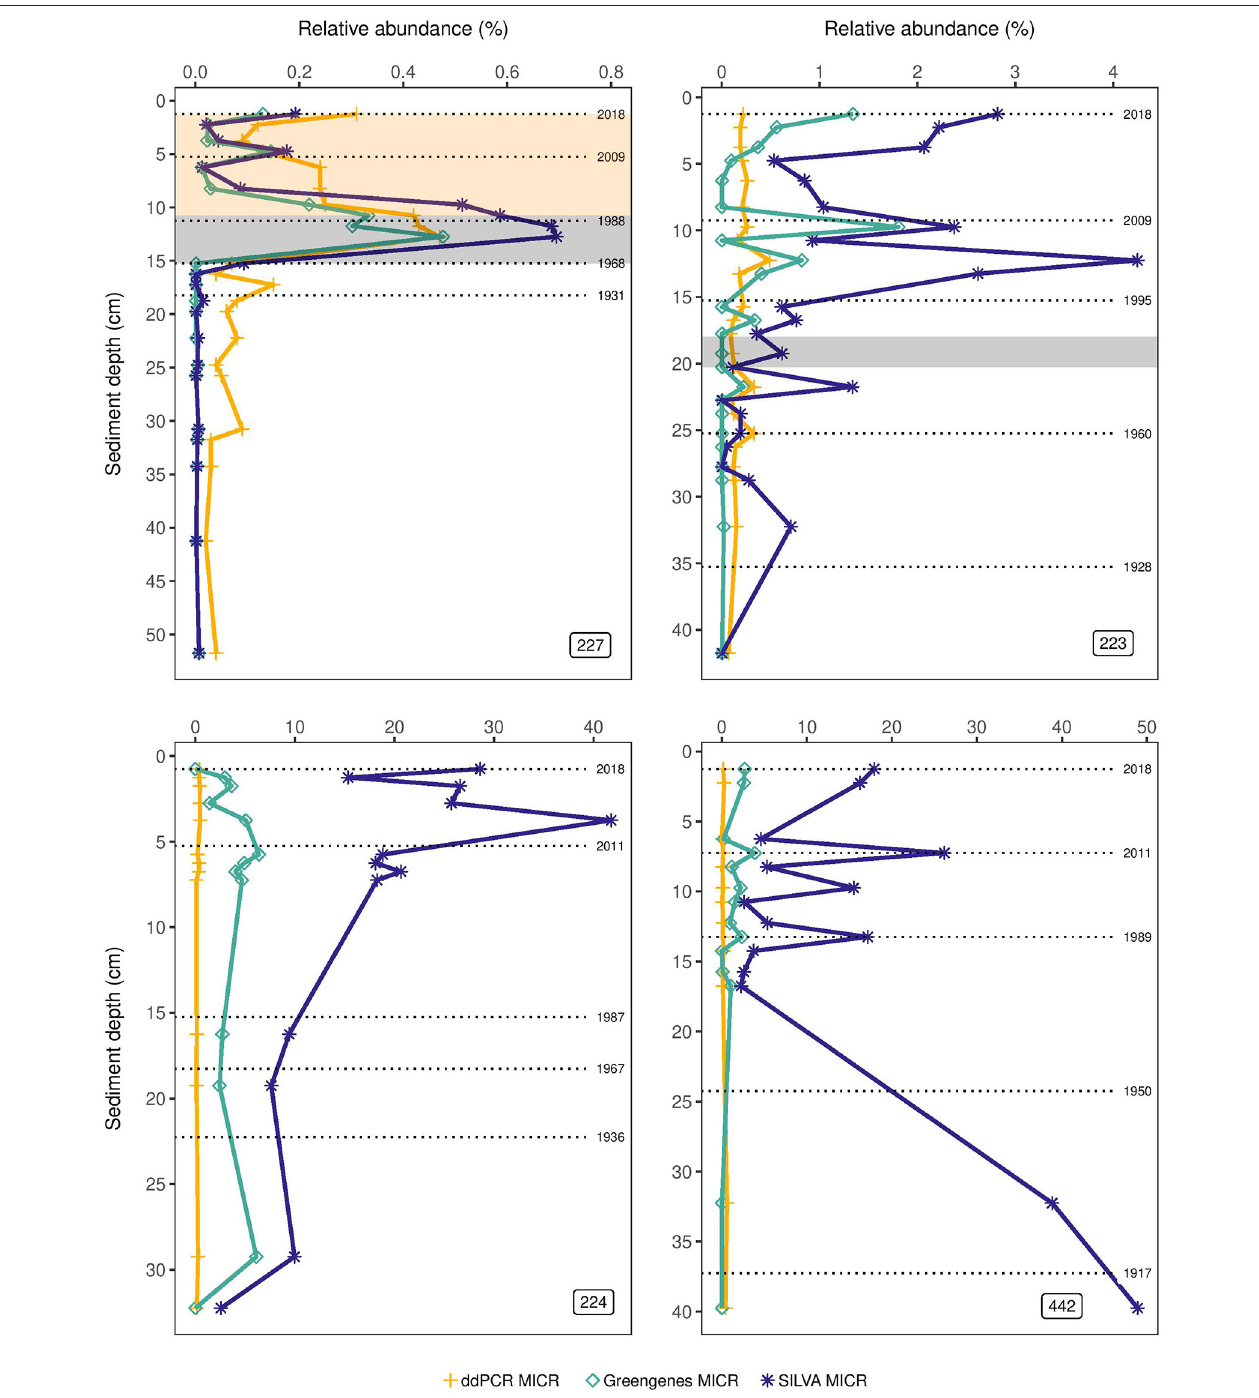
FIGURE 2 | Percent abundance of the Microcystis genus (MICR) in lake sediment cores of the Experimental Lakes Area, Canada, from manipulated lakes 227 and 223, along with reference lakes 224 and 442, as determined through droplet digital PCR (ddPCR) and through high-throughput sequencing (HTS) using the SILVA and Greengenes databases. The gray shading in the top left plot corresponds to the period of phosphorus and nitrogen loading in Lake 227 (1969–1989), while the beige shading corresponds to the period of phosphorus loading only (1990–2018). The gray shading in the top right plot corresponds to the period of sulfuric acid loading in Lake 223